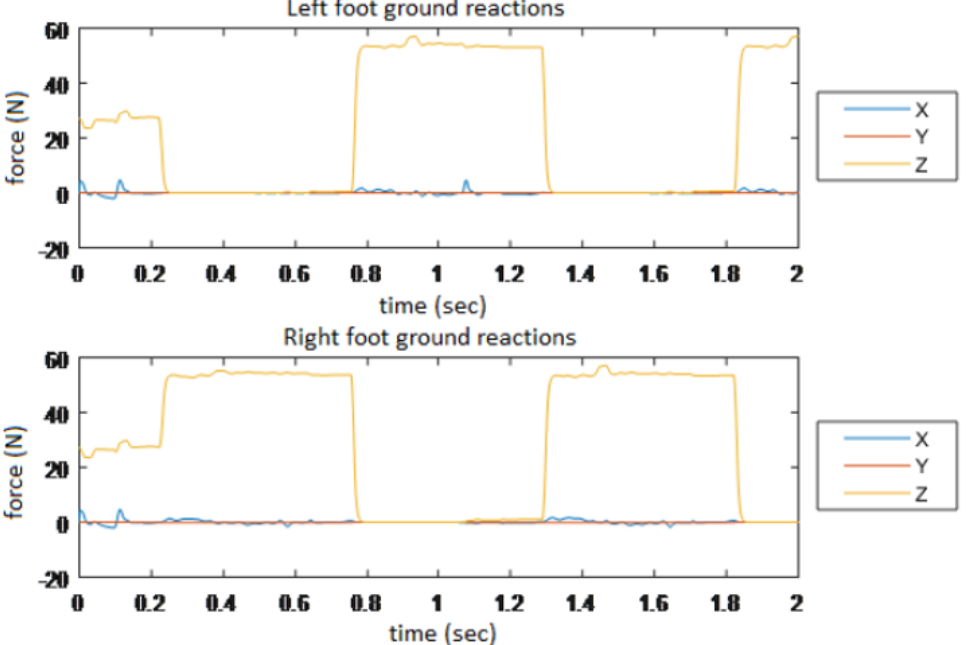
Figure 8. Left and right foot ground reaction forces Fx, Fy and Fz obtained for the imposed robot gait presented in Figures 4 and